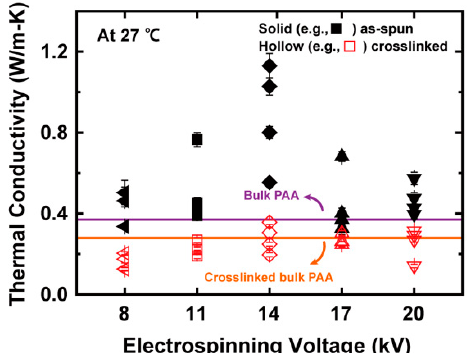
Figure 8. Thermal conductivity values of PAA NFs at 27 °C for various electrospinning voltages. The thermal conductivities were obtained from four different NFs for each electrospinning voltage. The five different electrospinning voltages of 8, 11, 14, 17, and 20 kV correspond to the symbols of a left-pointing triangle ( ◀ ), a square ( ◼ ), a diamond ( ◆ ), a triangle ( ▲ ), and an inverted triangle ( ▼ ), respectively. Also, the solid and hollow symbols denote as-spun and crosslinked PAA nanofibers, respectively, and the purple and orange solid lines stand for the thermal conductivities of bulk PAA and crosslinked bulk PAA, respectively. The optimal value at 14 kV occurred due to a trade-off between the electrospinning voltage and the flight time, which affected the chain alignment.